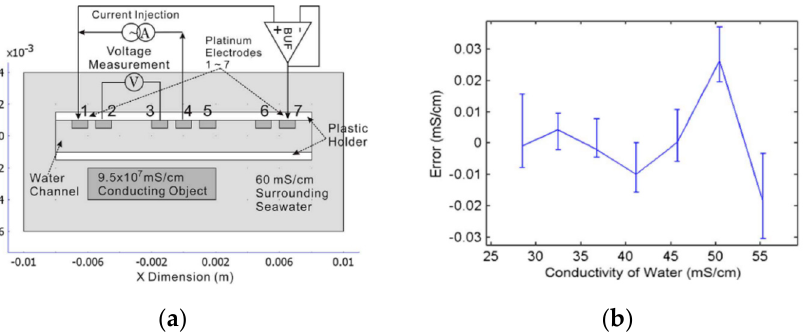
Figure 4. Seven − electrode conductivity sensor: ( a ) structure and measuring principle ( b ) errors in measuring seven conductivity points.